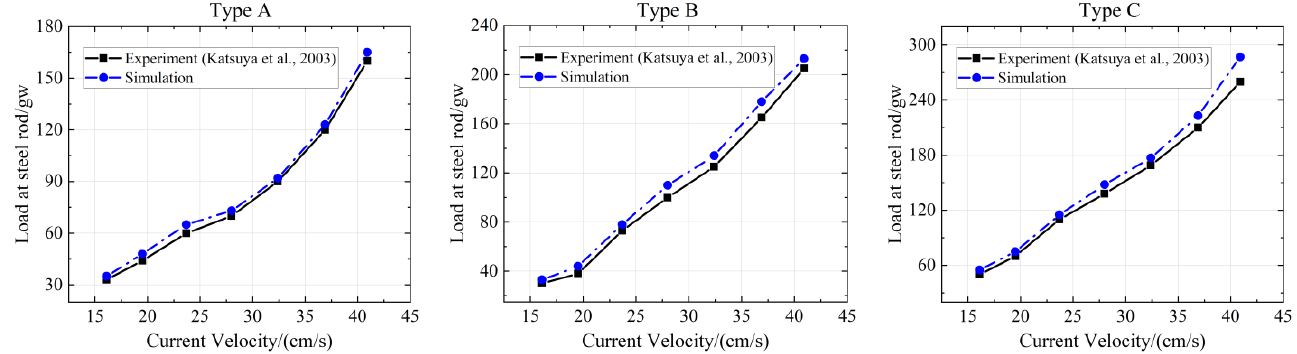
Figure 8. The comparison of the flow component for loads acting on the steel rod [36].